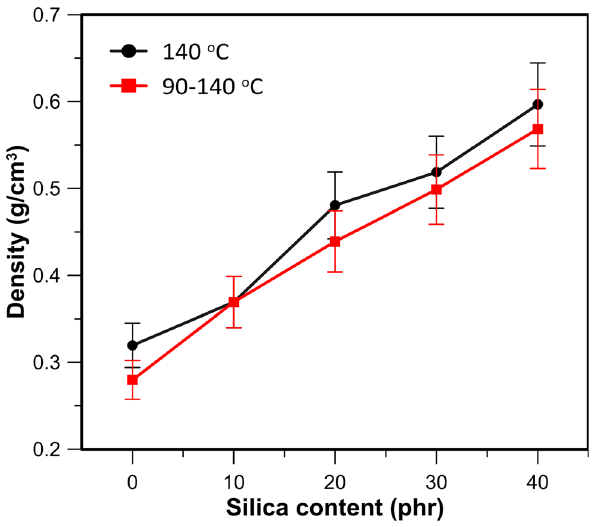
Figure 3: Density of natural rubber composites vs silica content.